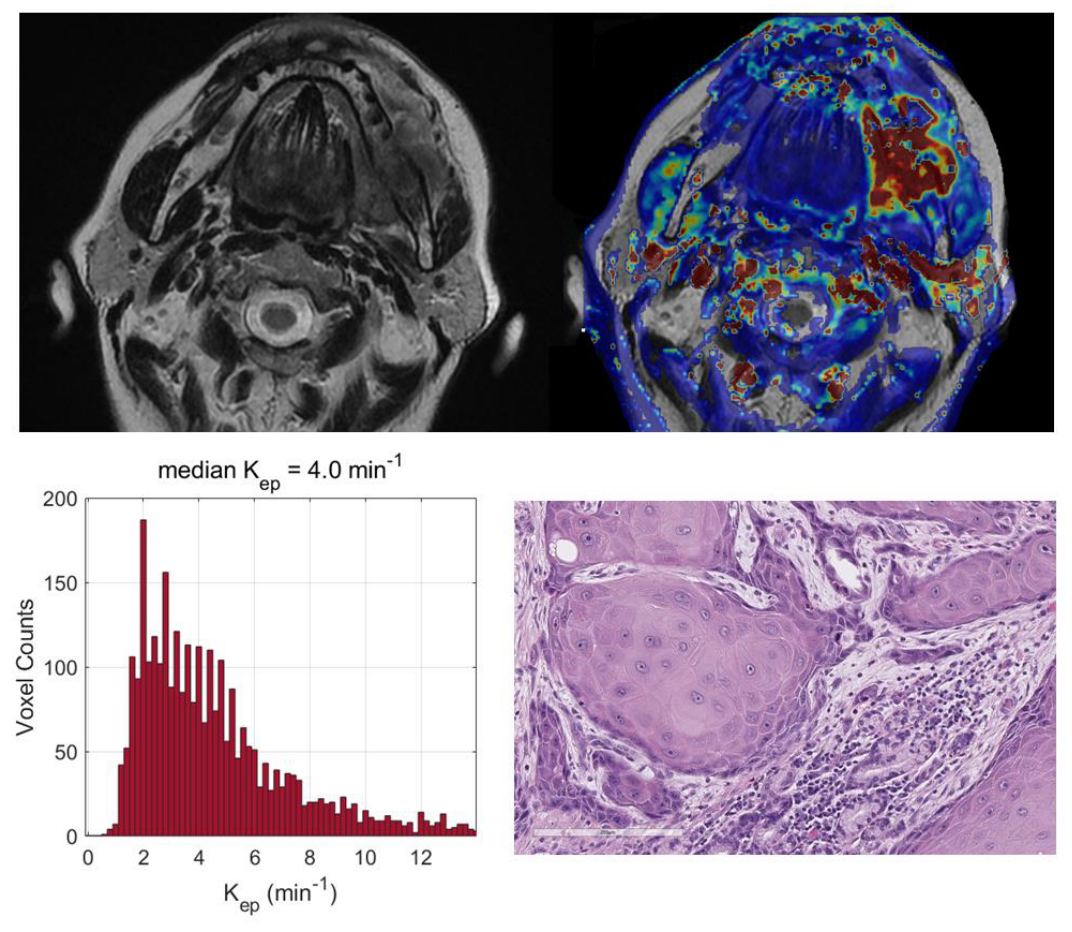
Figure 6. Top (from left to right): central section of a retromolar trigon lesion in a 63-year-old woman on T2-weighted images and on the corresponding map of K ep (min −1 ), showing a well-vascularized tumor (median K ep value = 4.0 min −1 ). Bottom (from left to right): histograms of K ep values derived from the entire tumor volume and a well-differentiated squamous cell carcinoma (hematoxylin – eosin; original magnification: 20×).